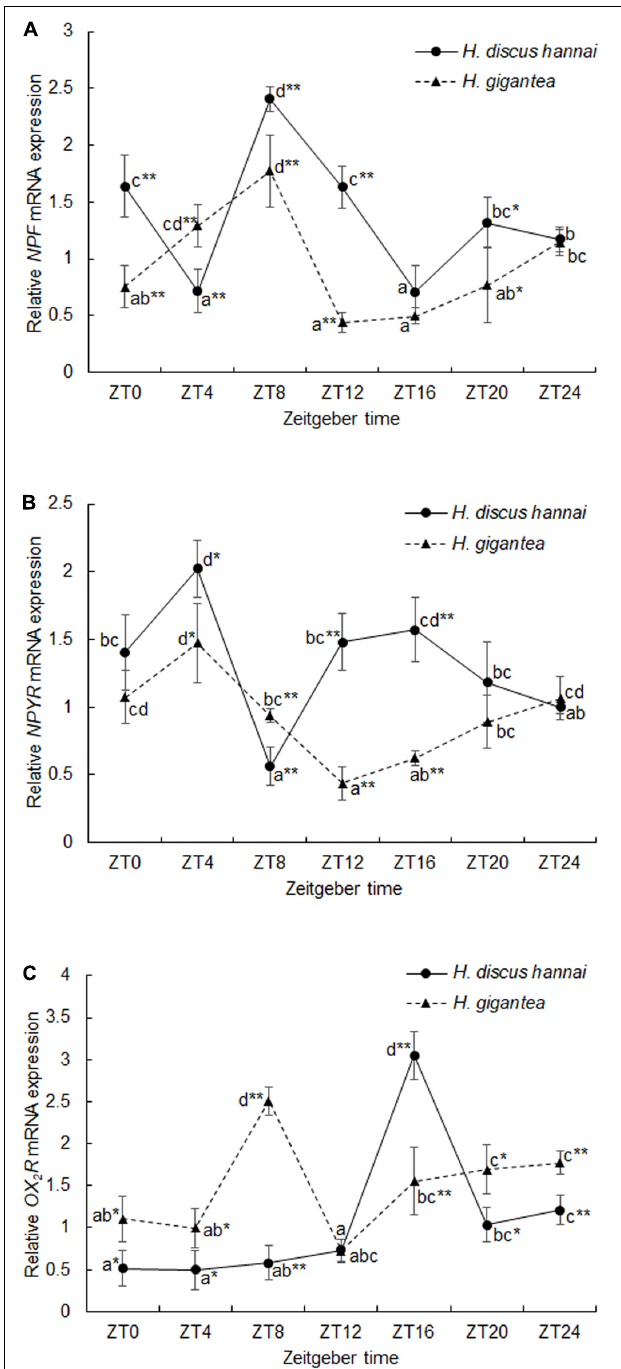
FIGURE 4 | Expression levels of NPF (A) , NPYR (B) , and OX 2 R (C) in Haliotis discus hannai and Haliotis gigantea . Values are expressed as mean ± SE ( n = 4). Treatments with different letters are significantly different at different sampling times in the same species ( P < 0.05). “*” and “**” indicate significant differences at P < 0.05 and P < 0.01, respectively, in the relative expression levels of feeding-related genes at the same sampling time in different species. No label indicates no significant difference at P < 0.05 in the relative expression levels of feeding-related genes at the same sampling time in the same species.